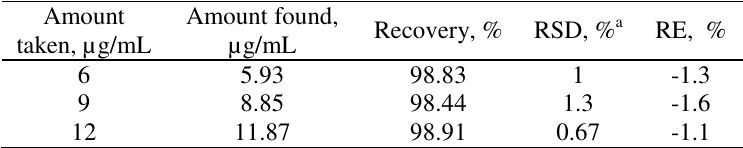
Table 1. Evaluation of accuracy and precision for the proposed method.